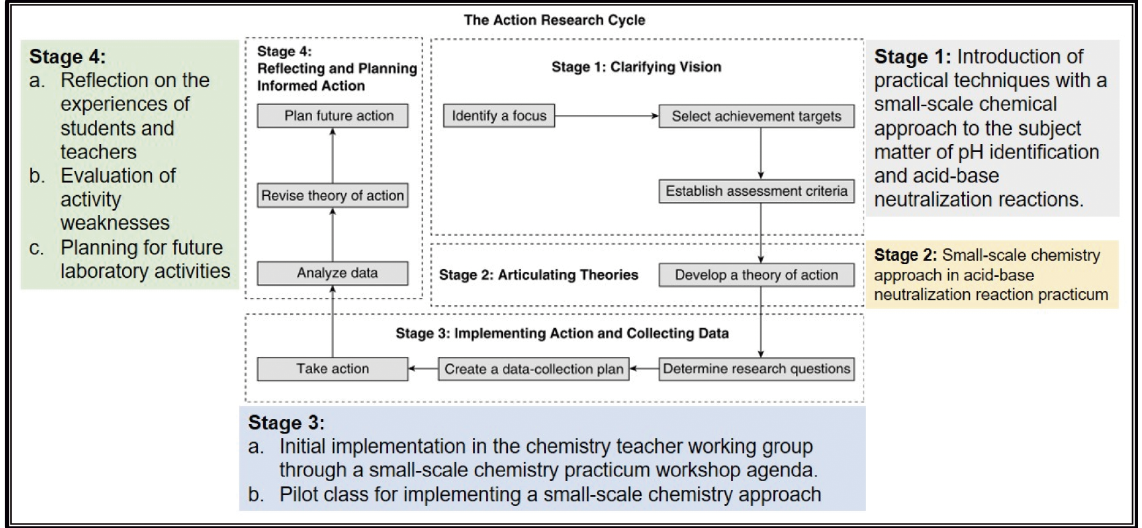
Figure 1. The action research cycle (Sagor,